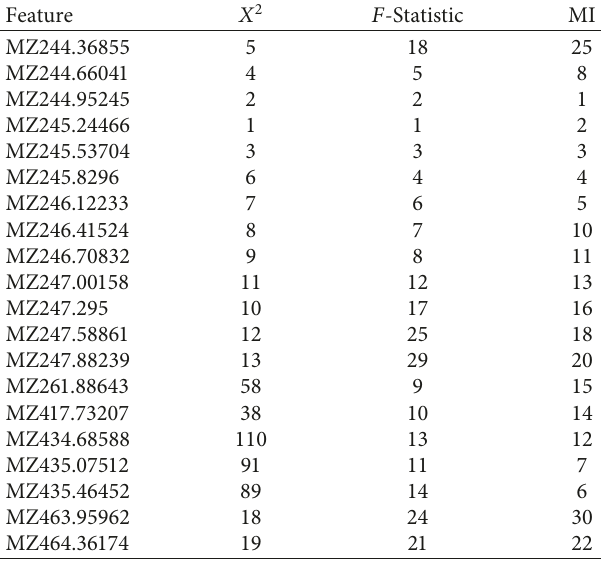
Table 3: Feature score table (FST) for the ovarian cancer dataset.